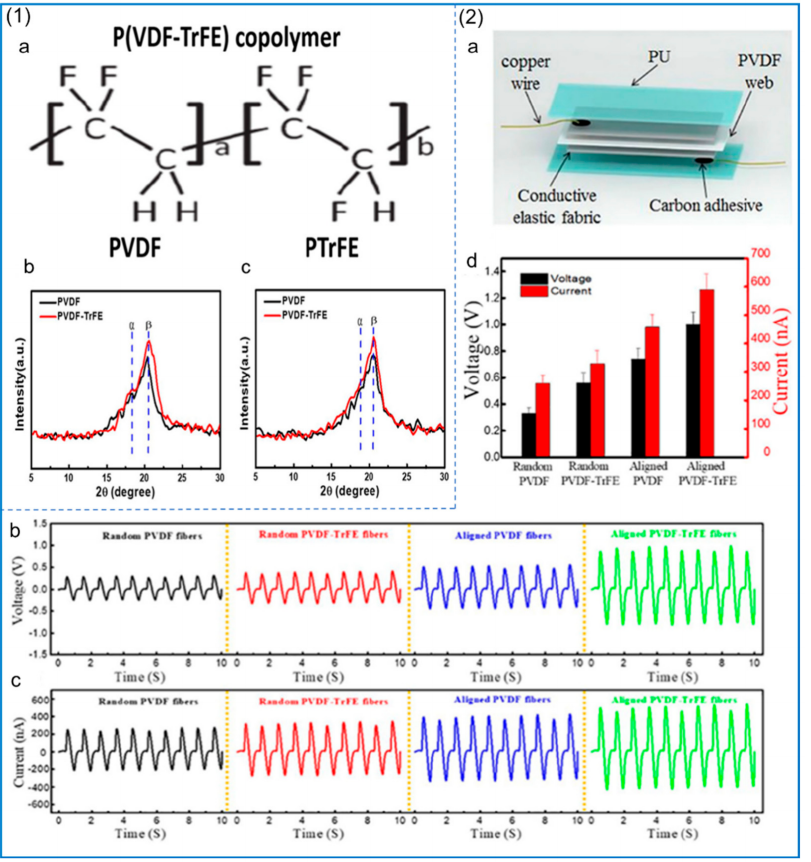
Figure 8. ( 1 ) Analysis of PVDF and PVDF–TRFE NFs, and ( a ) Molecular structure of PVDF–TRFE. ( b ) XRD patterns of randomly oriented PVDF and PVDF–TRFE NFs. ( c ) XRD patterns of PVDF and PVDF–TRFE fibers arranged in order. Reprinted with permission from Ref. [127],